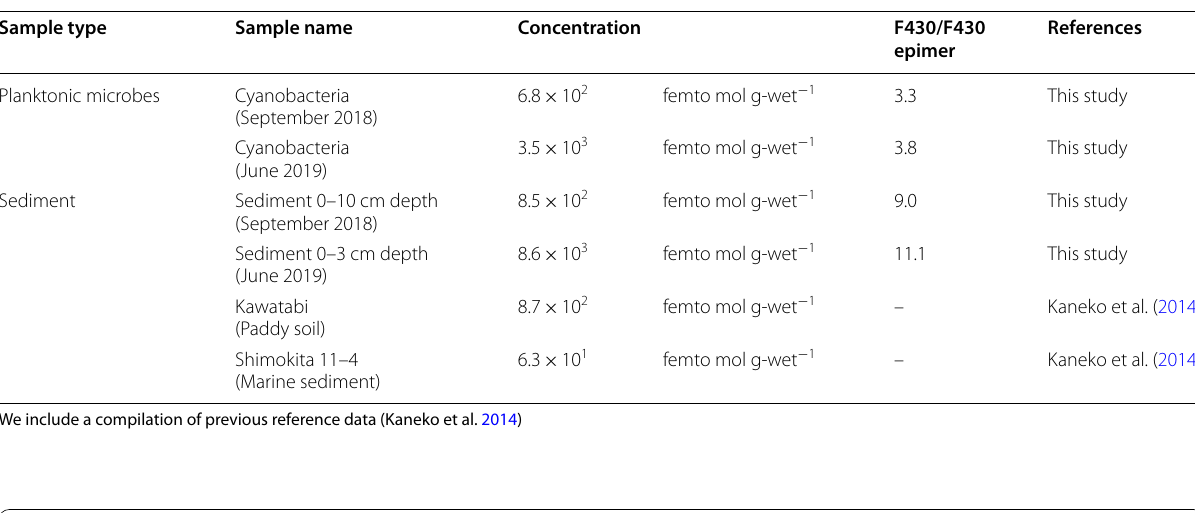
Table 2 Concentrations of coenzyme F430 and its epimer ratios in the planktonic and sediment samples collected from Lake Suwa